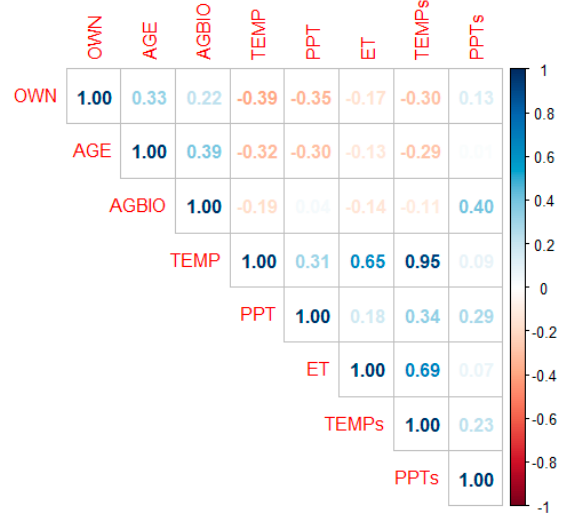
Figure 3. Correlation between the climate and other variables.